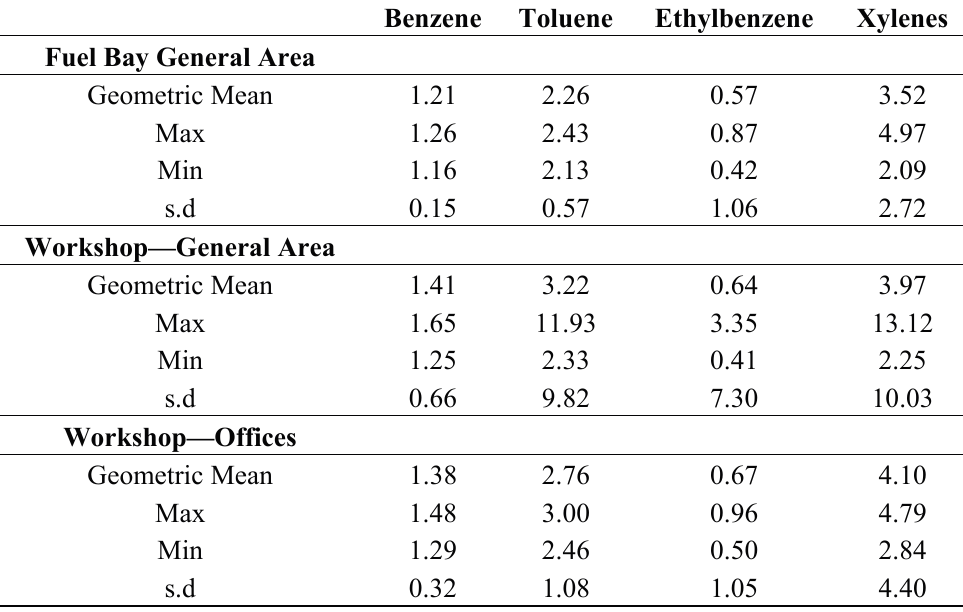
Table 3. Average BTEX concentrations (in ppb) from Radiello passive samplers in the refueling bay and workshop (average atmospheric temperature during the monitoring period was 14.3 °C; six samplers were placed in each workspace).